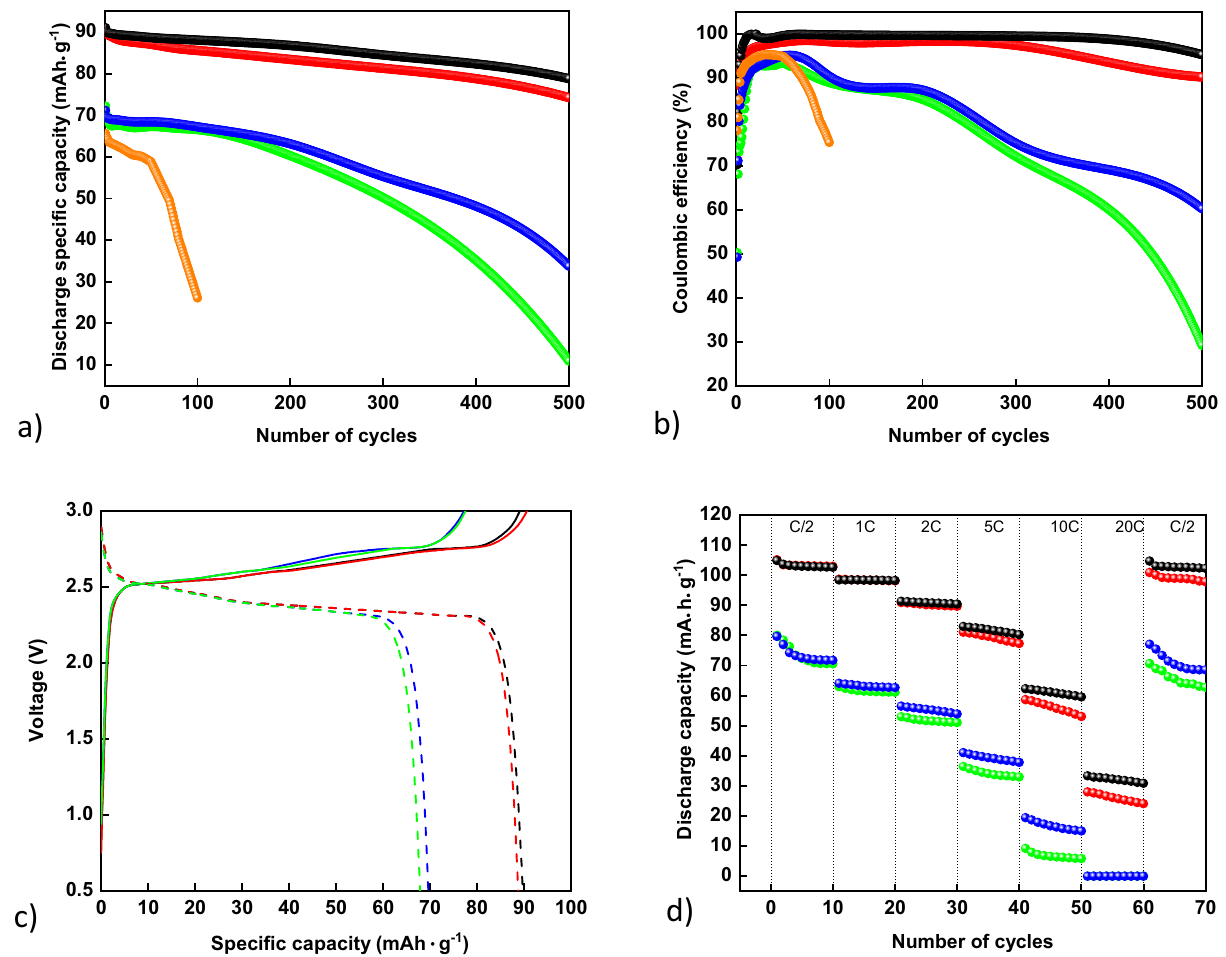
Figure 4. Electrochemical performance of LTO/LMO-based full battery cells. ( a ) Cycling stability during discharging, ( b ) Coulombic efficiency, ( c ) Voltage profiles for the 10th cycle, ( d ) Rate performance. Black—Li[TFSI] (1) :(C 2 OC 2 Pyr-C 2 OC 2 -C 2 OC 2 Pyr)[TFSI] 2(1) :H 2 O (3) ; red—Li[TFSI] (1) :(C 4 Pyr-C 2 OC 2 -C 4 Pyr) [TFSI] 2(1) :H 2 O (3) , blue—Li[TFSI] (1) :(C 2 OC 2 Pip-C 2 OC 2 -C 2 OC 2 Pip)[TFSI] 2(1) :H 2 O (3) ; green—Li[TFSI] (1) :(C 4 Pip-